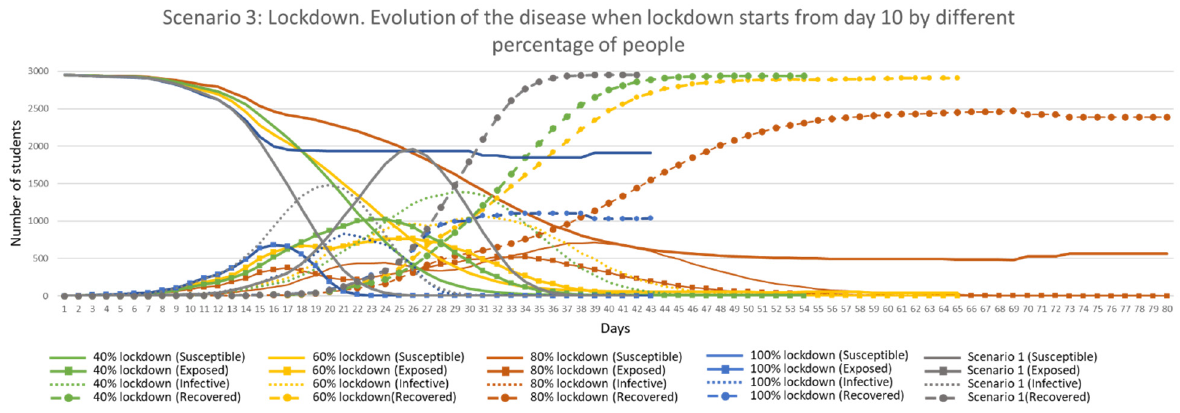
Figure 16. Average evolution in time of the disease in Scenario 3 ‘Lockdown’ when lockdown is followed by different percentage of people from Days 10, as compared to Scenario 1. Similar graphs for Days 10 and 15 are included in Appendix F.